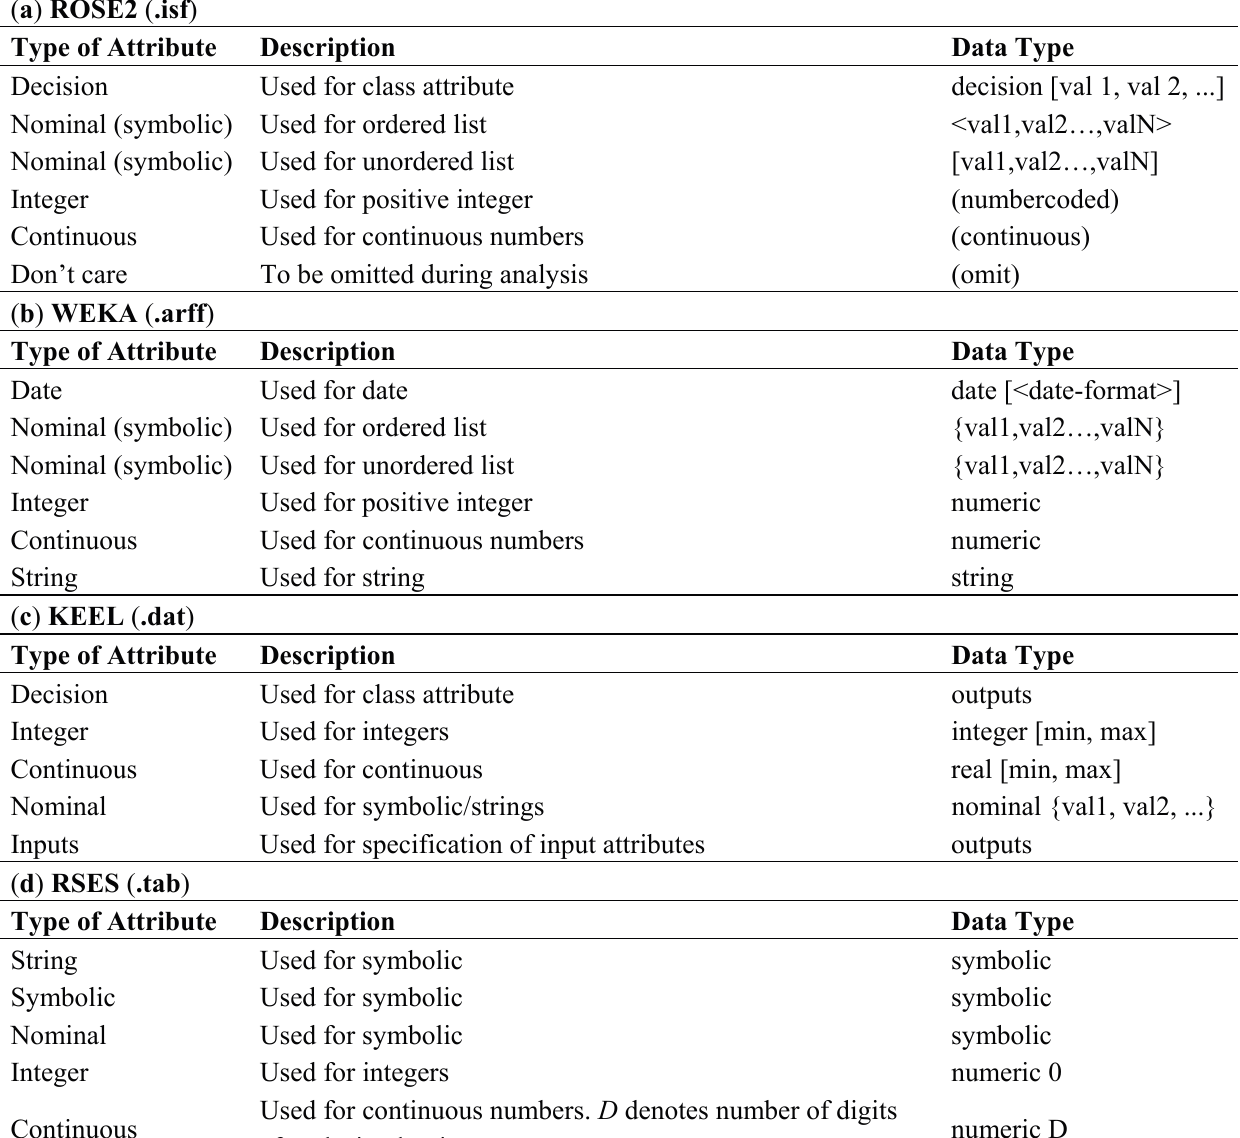
Table 1. List of the supported data types in “data modeler” for ROSE2 , WEKA , KEEL and RSES data analysis